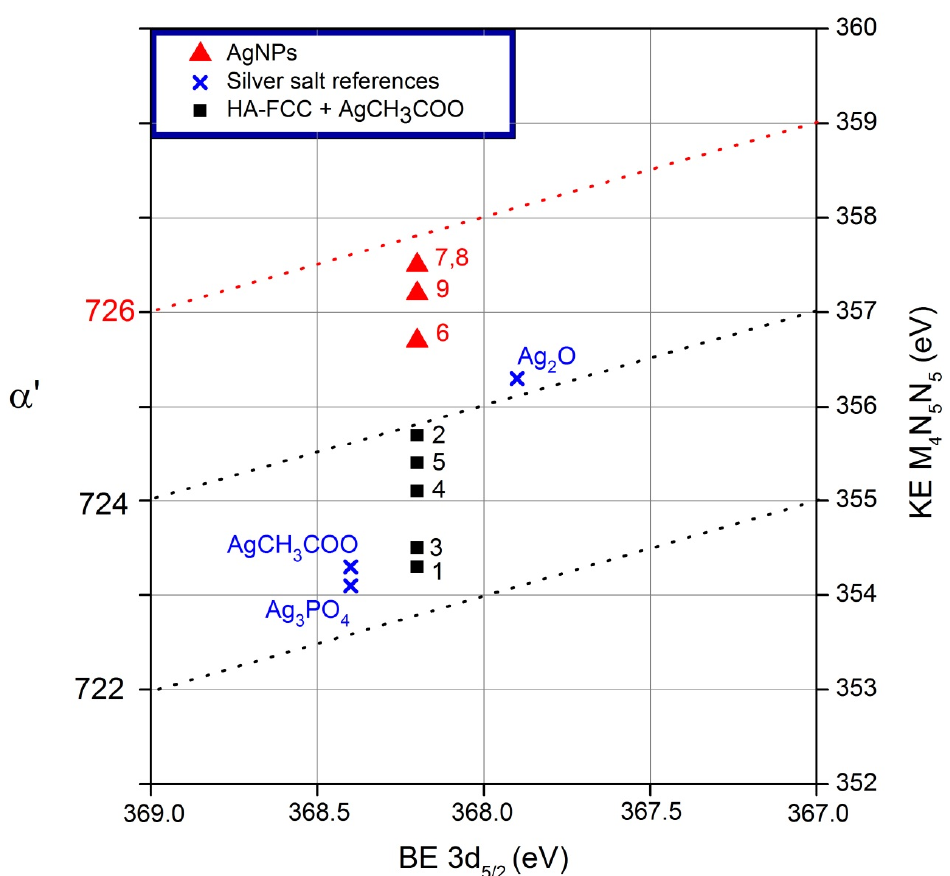
Figure 7. Wagner plot for the experimental results of Auger parameter determined for all the samples. Sample numbers are also indicated in the plot. Dashed lines for eye guidance—constant values of α’. The values for Ag NPs lie near to the literature data for metallic Ag (red dotted line).